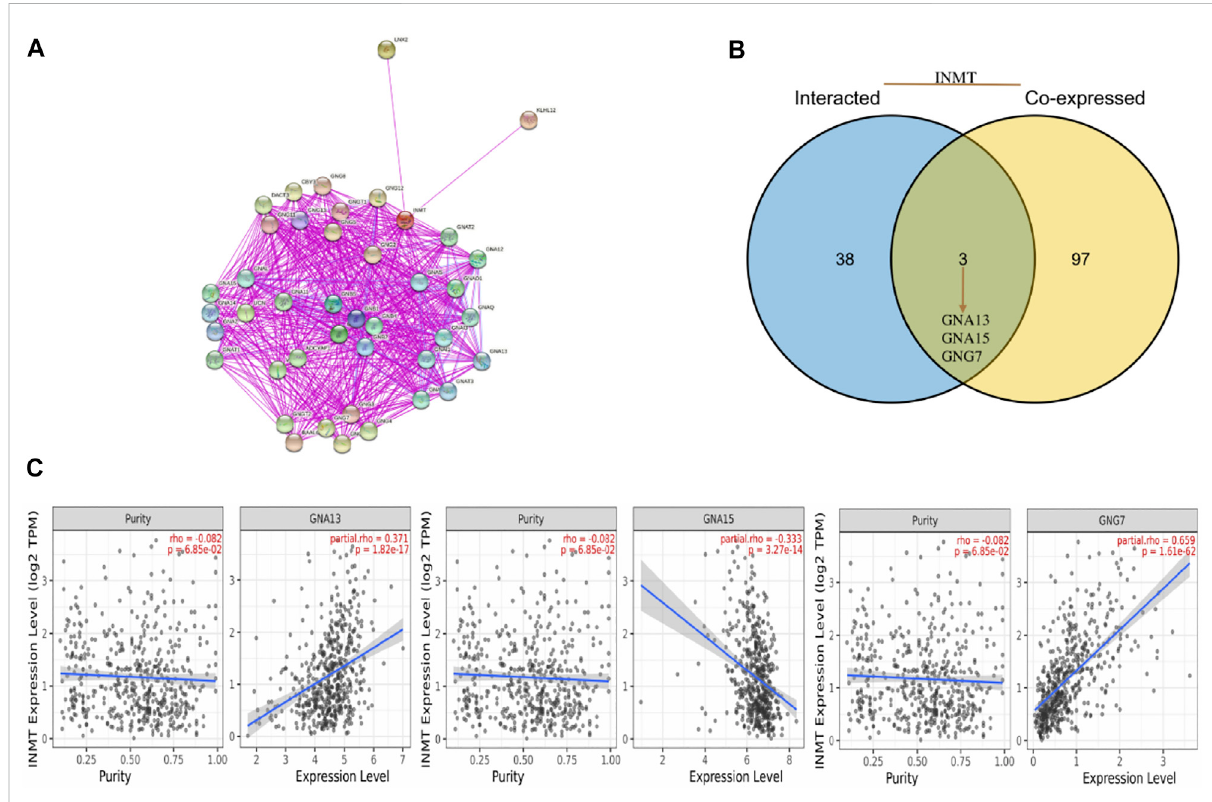
FIGURE 5 An analysis of INMT-relatedgenes based on PPI networks. (A) A network visualization for INMT-binding proteins was created using the STRING database. (B) An intersection analysis was performed between co-expressed genes and genes that interacted with INMT. (C) INMT expression correlates with screened genes including GNA13, GNA15, and